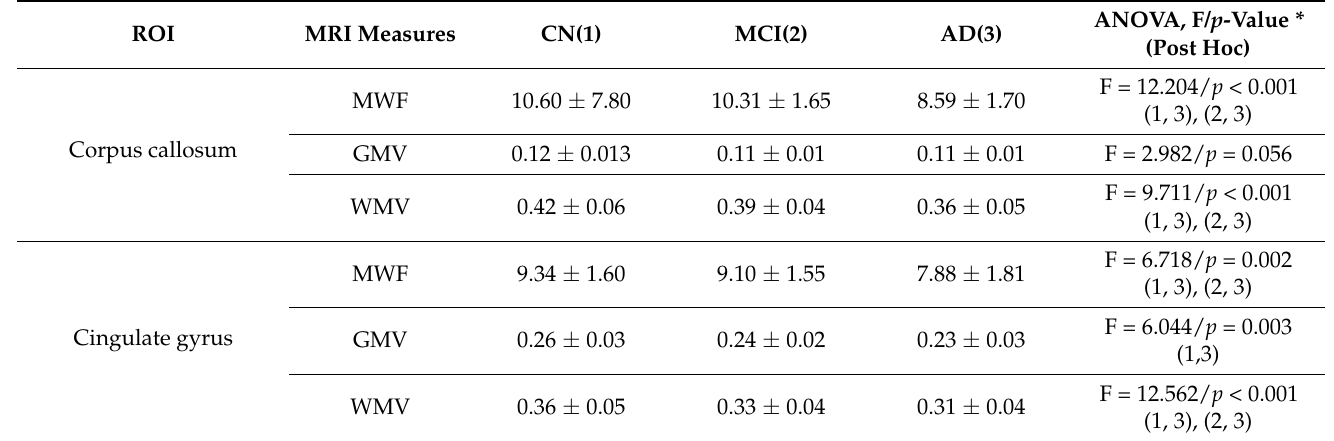
Table 2. Results of comparisons of MRI measures between the three participant groups in specific brain areas.